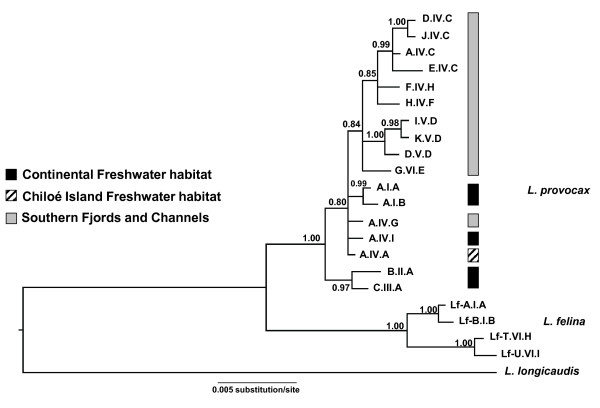
Bayesian phylogenetic tree constructed using 2151 bp of mitochondrial DNA CR, ND5 and Cyt-b concatenated haplotypes. Four L. felina haplotyes were incorporated on the phylogeny, as well L. longicaudis as outgroup. Nodes support values are presented as Bayesian posterior probabilities. Black colours represent haplotypes from continental freshwater habitat, diagonal black lines represent rivers from Chiloé Island and gray colour is haplotypes from Southern Fjords and Channels.